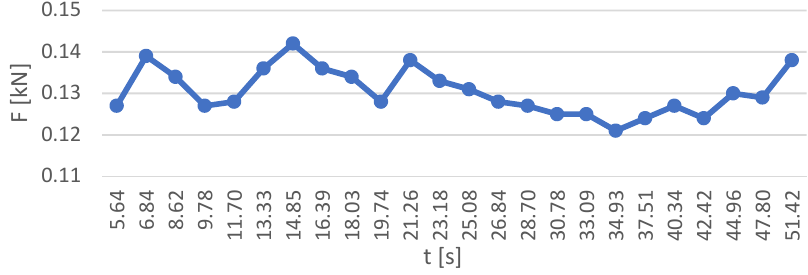
Figure 4. Evolution of maximum forces per cycle—10 kg load.